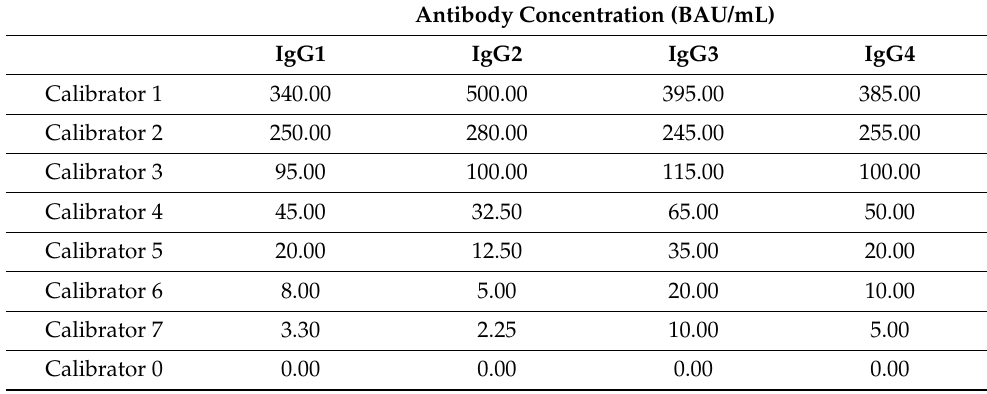
Table 5. Calibrator values for each anti-S protein (RBD) antibody subclass.